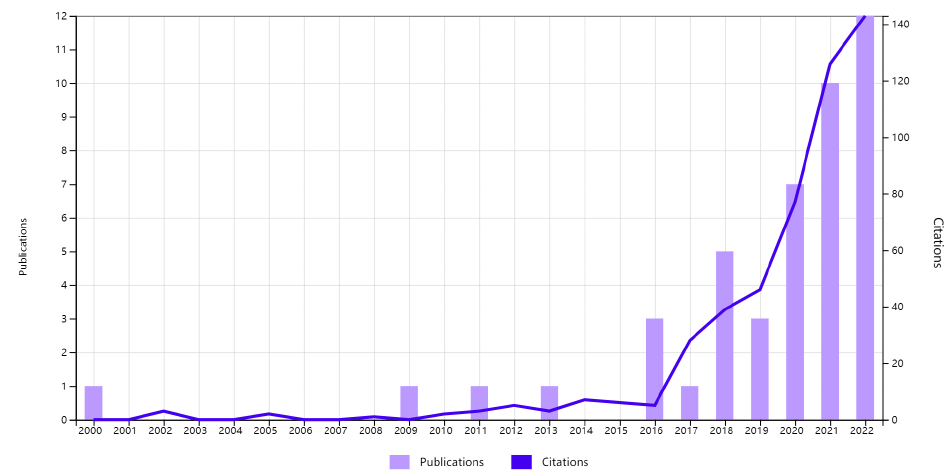
Figure 1. Number of publications and citation frequency of tumor big data